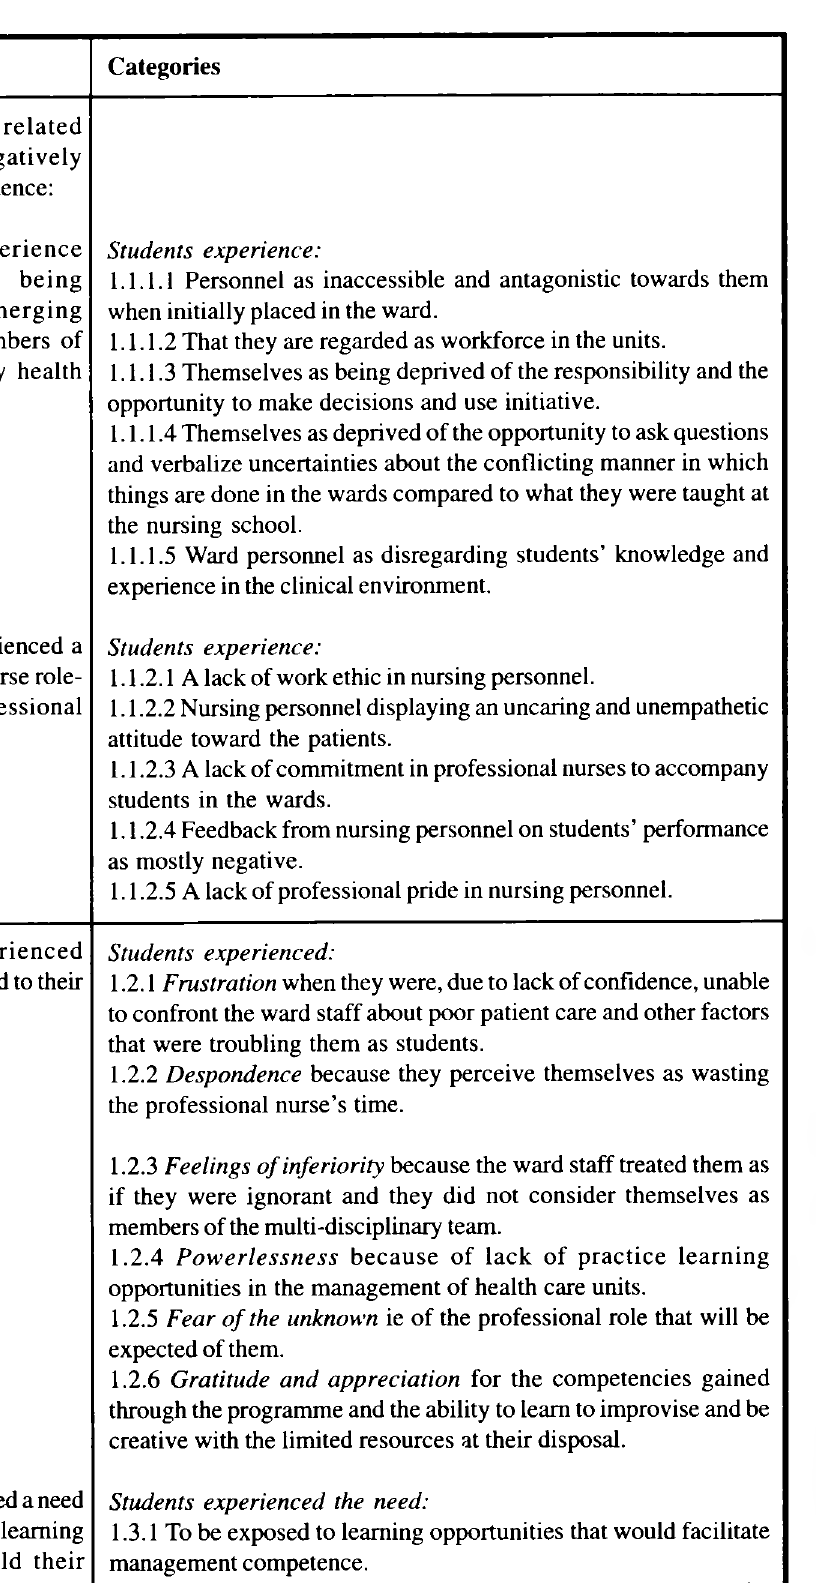
Table 2: Identified Themes/Results Of The Study Relating To Final Year Nursing Students